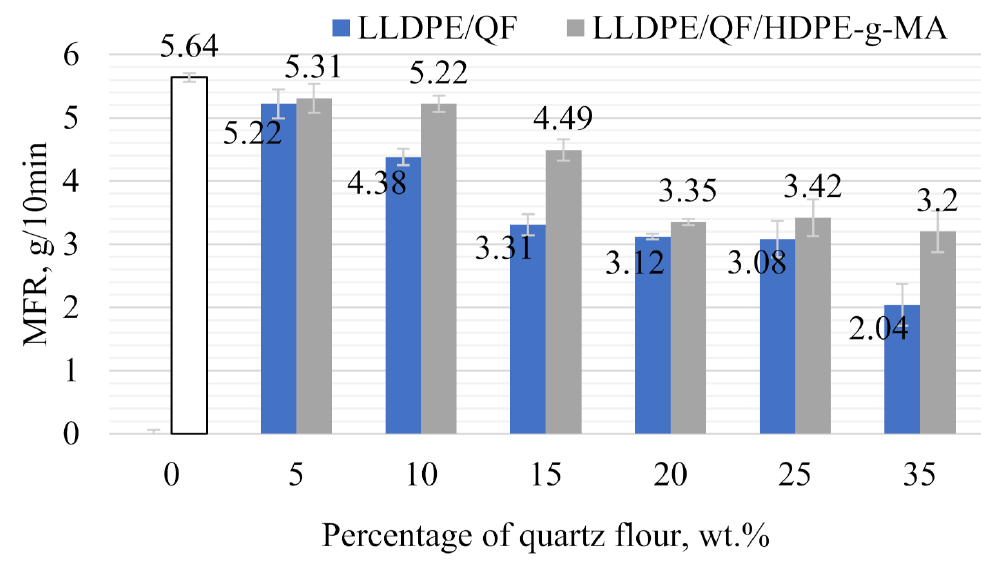
Figure 7. Melt flow rate of LLDPE/QF and LLDPE/QF/HDPE-g-MA.